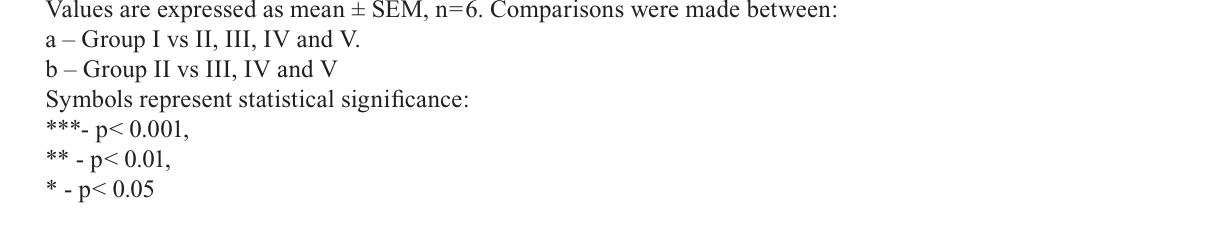
TABLE IV- E ffect on arthritic pain index